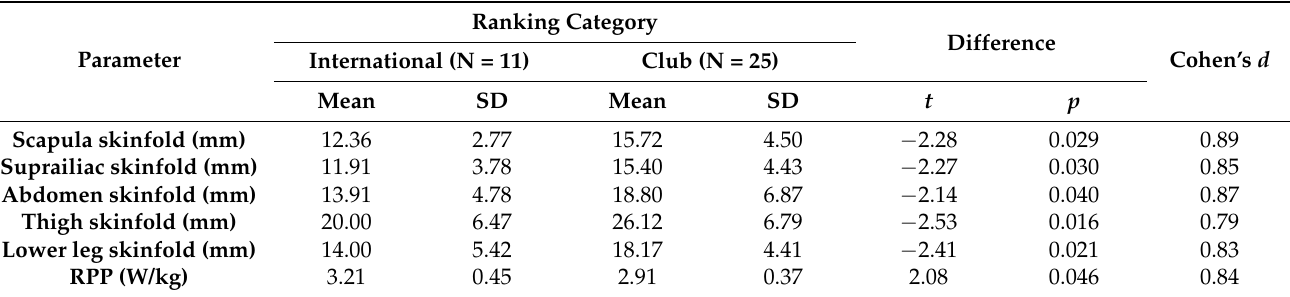
Table 2. Comparison of arithmetic means of younger junior women’s anthropometric, physiological and motoric parameters depending on the ranking